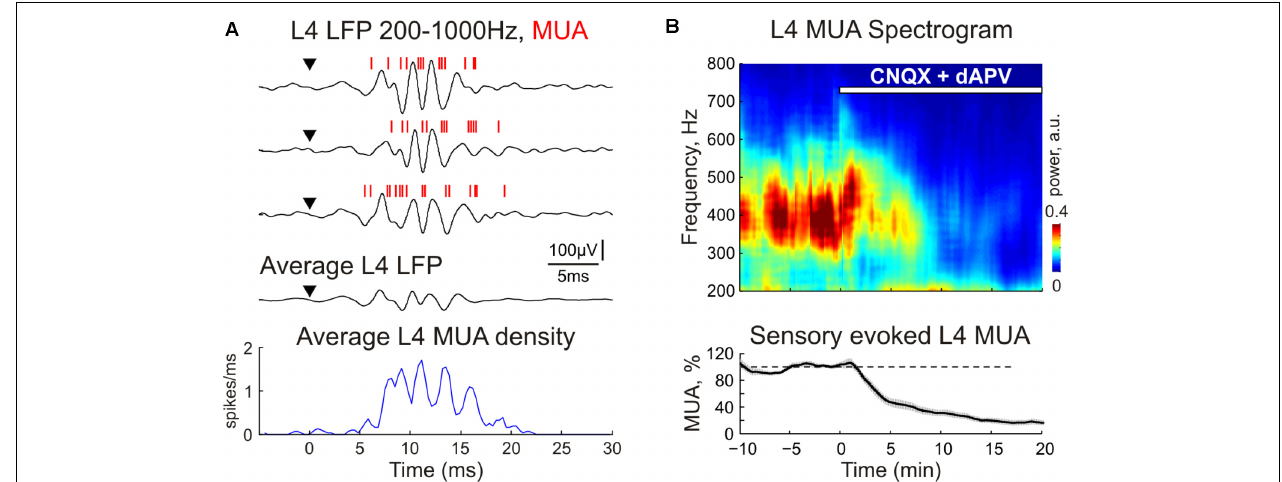
FIGURE 4 | The CNQX and dAPV effect on sensory evoked fast oscillations (FO) in cortical layer 4. (A) Three representative traces (after high-pass filtering, 200–1000 Hz) show fast L4 LFP and MUA oscillations evoked by sensory stimulation. Red bars overlaid on the LFP traces are detected spikes (MUA). Stimulus onset is indicated by the arrowhead. Corresponding PSTH of evoked MUA averaged over 30 responses is shown under the LFP traces. (B) Top , averaged power spectrum of evoked L4 MUA before and during CNQX/dAPV application (application time is shown with a white bar). Bottom , the time-course of sensory-evoked (early + late) MUA suppression by CNQX/dAPV. Shaded area shows SE bands. Data were averaged over 11 animals and two concentrations, 170 µ M CNQX/700 µ M dAPV and 0.5 mM CNQX/2 mM